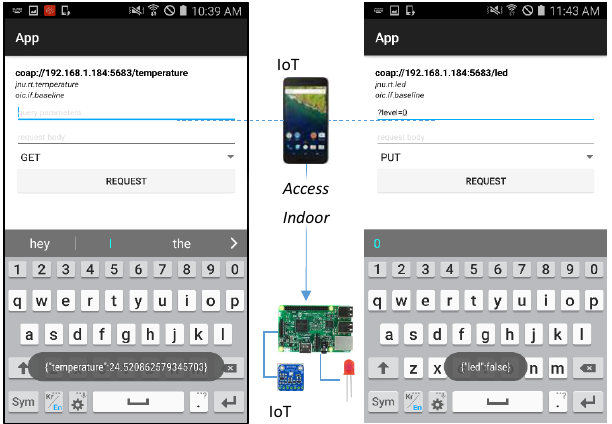
Figure 14. Fragment of RAML definition for registering WSP.